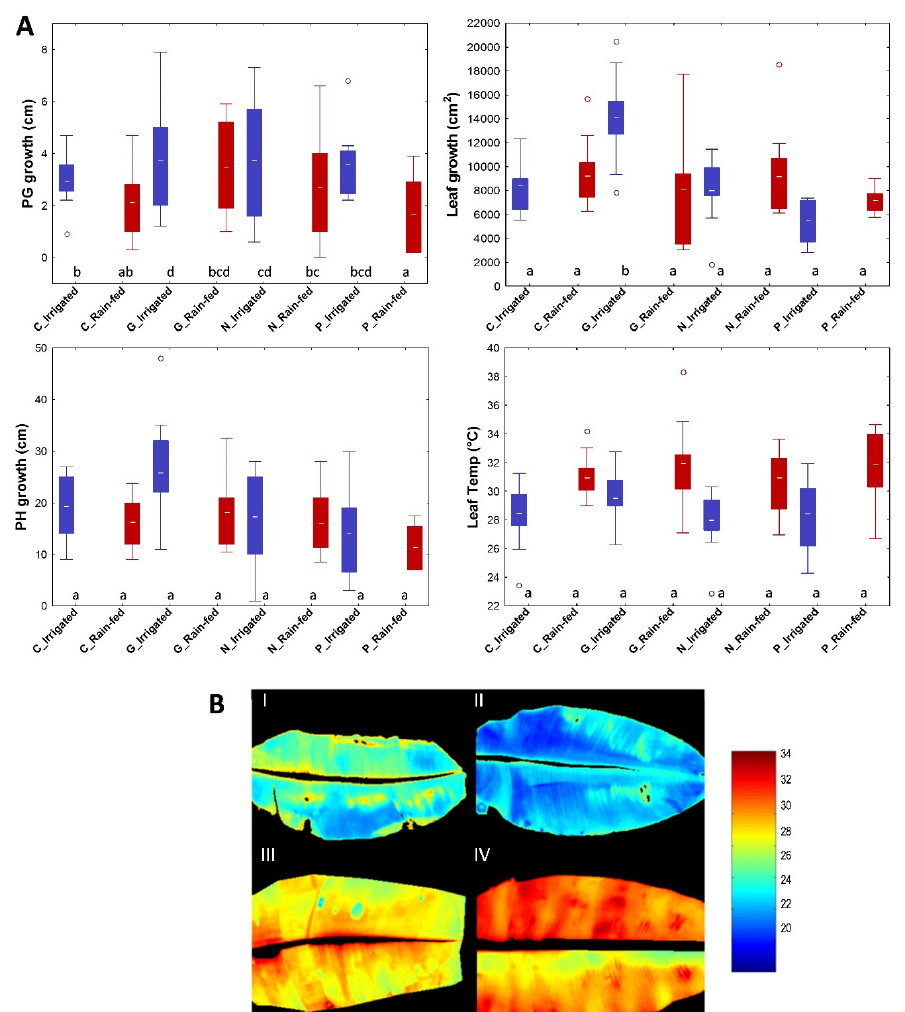
Figure 3. Effect of seasonal drought on early growth parameters and leaf lamina temperature. ( A ) Boxplots for growth in pseudostem height, girth and leaf area between 10 and 40 days after stopping irrigation, and for mean leaf temperatures at 47– 48 days after stopping irrigation. Different letters indicate significant differences based on comparison over genotypes and treatments (LSD; α = 0.05). Boxes represent the interquartile range (25–75%) and whiskers the non-outlier range. Horizontal lines inside boxes indicate the mean values. Outliers are indicated as dots. C: “Cachaco”, G: “Guyod”, N: “Nakitengwa”, P: “Pahang”. ( B ) Lamina temperatures of the two triploid banana genotypes used in this study: (I) Irrigated “Cachaco”; (II) Irrigated “Nakitengwa”; (III) Rain-fed “Cachaco”; (IV) Rain-fed “Nakitengwa”. Higher leaf temperatures indicate lower stomatal conductance and vice versa. N = 10/10 (irrigated/rain-fed). PH: pseudostem height; PG: pseudostem girth; Temp: